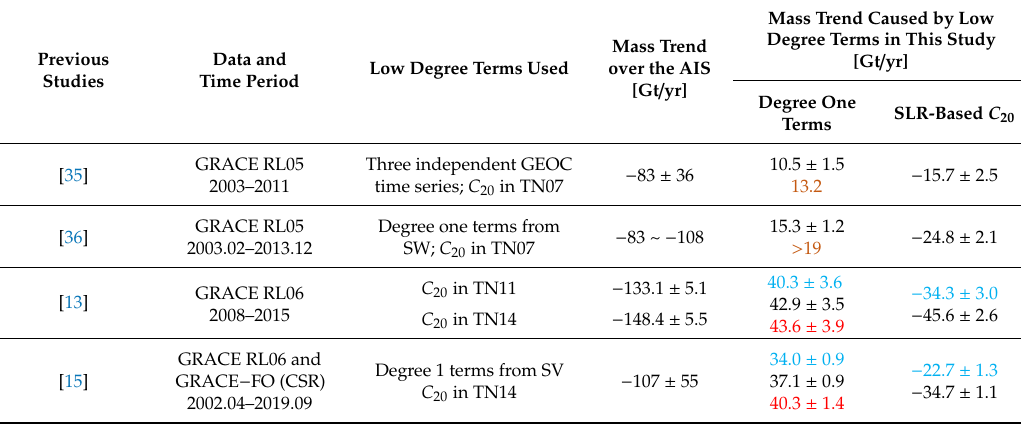
Table 7. The trends of mass variations over the AIS in previous studies and the contributions from low degree terms in this study. Note, mass trends caused by low degree terms corresponding to TN11, TN14, and SV for GRACE RL06 data over the AIS in this study are marked separately in light blue, black, and red. For GRACE RL05, the impacts of low degree terms on the trend of the AIS mass variations in our study are shown in black, with the corresponding results in previous studies shown in